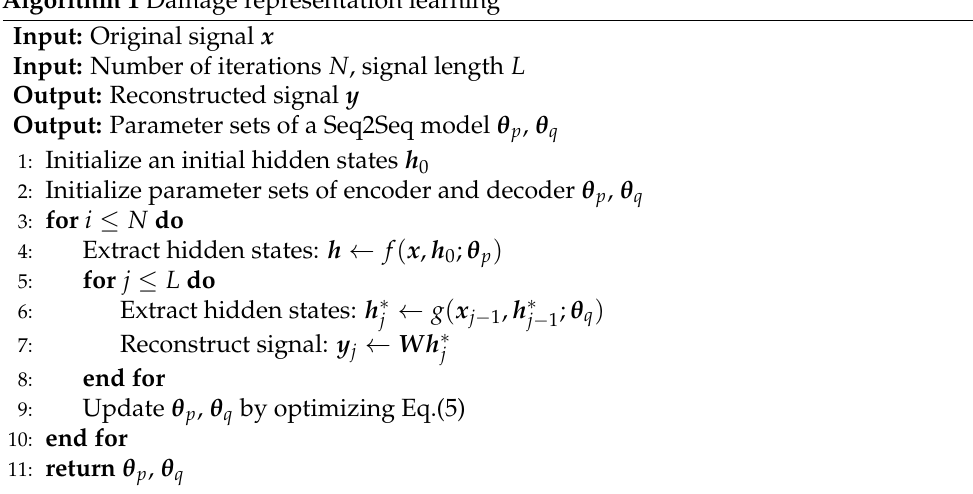
Algorithm 1 Damage representation